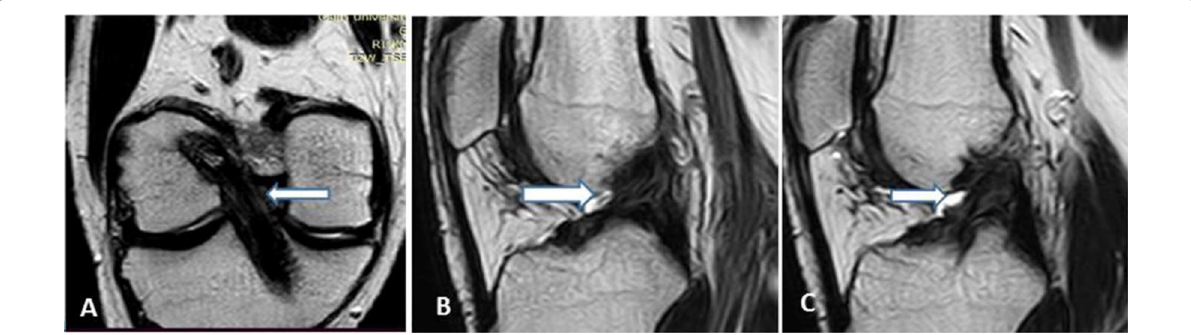
Fig. 3 a Oblique coronal T2, b and c oblique sagittal T2 WIs showing interstitial high signal elevation, thinning at the middle portion of the graft with a slight lax orientation suggesting a grade 1 injury (white arrows)